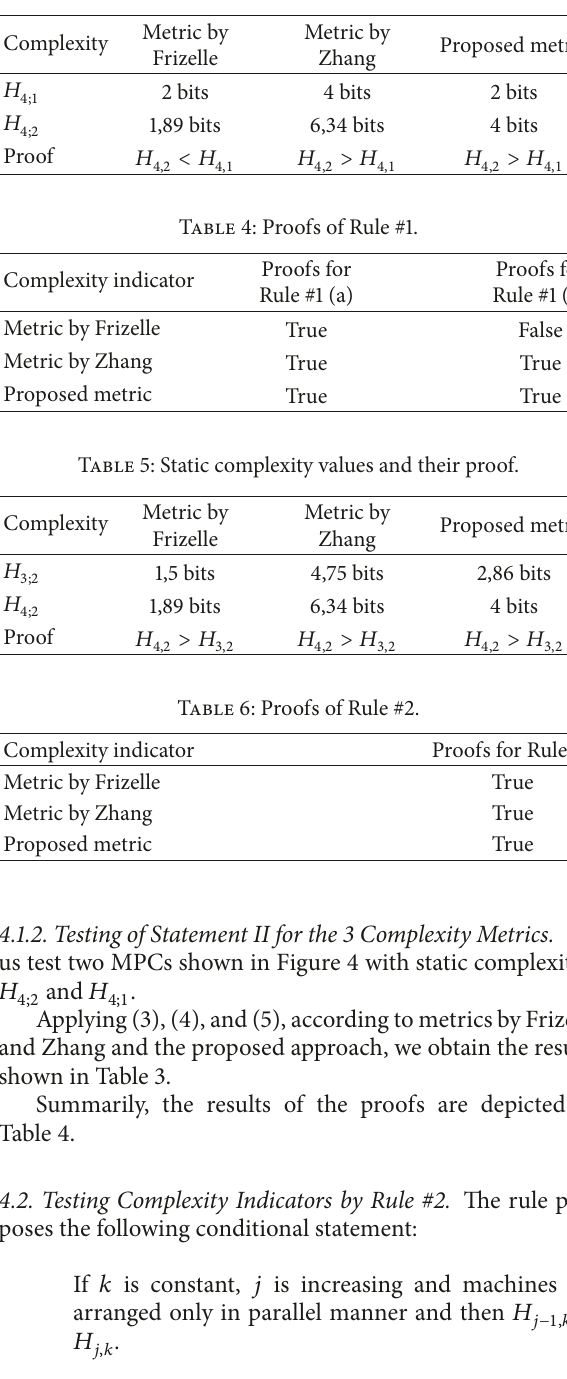
Table 3: Static complexity values and their proof.